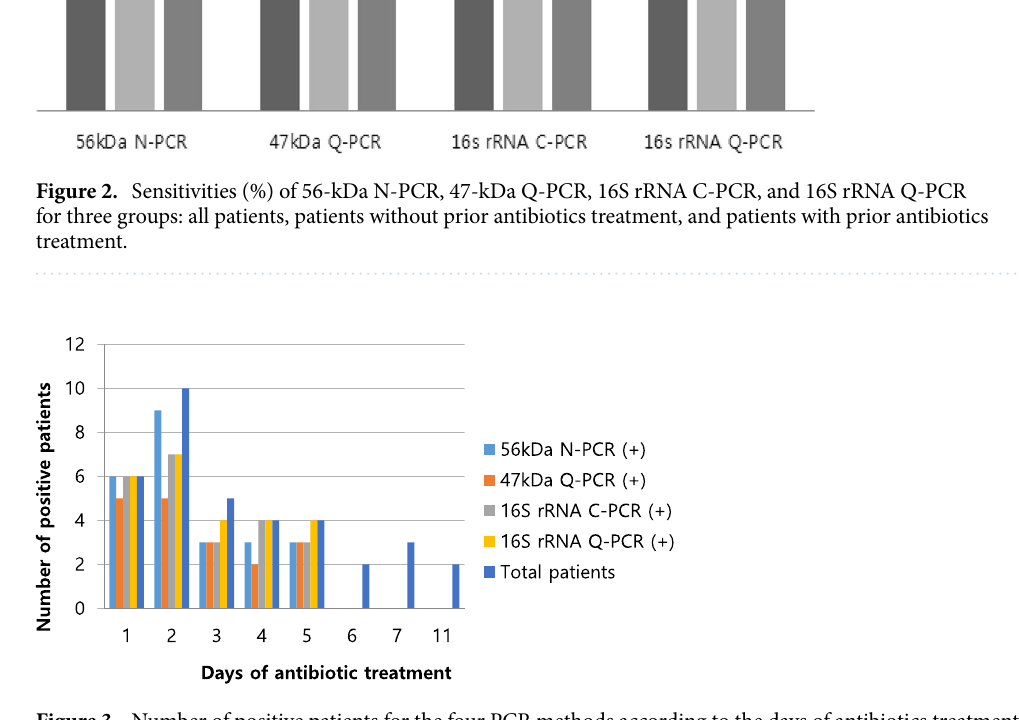
Figure 3. Number of positive patients for the four PCR methods according to the days of antibiotics treatment in 36 patients with prior antibiotics